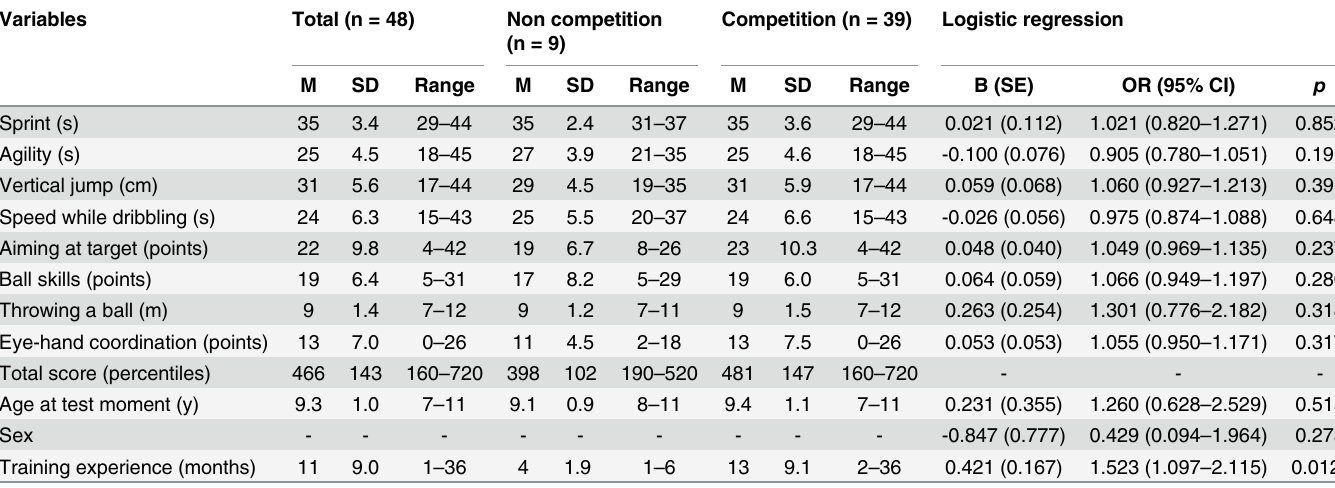
Table 2. Descriptive statistics perceptuo-motor skills assessment and logistic regression competition